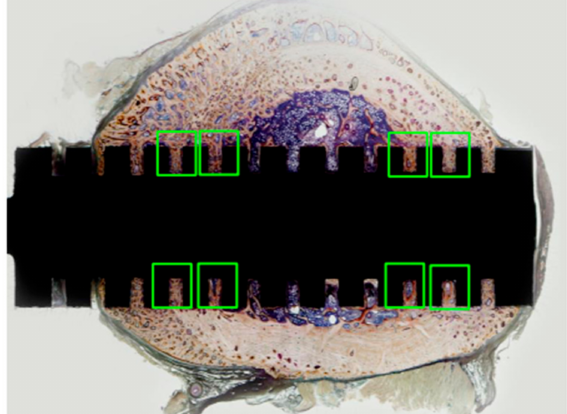
Figure 4. Cross-section of polished non-demineralized femur specimen (whole specimen). Patho- logical examination and bone histomorphometric assessment were focused on in the green-boxed areas, where the cortical bone contacted the slit portion of the implant, because bone formation was expected to be more active in those